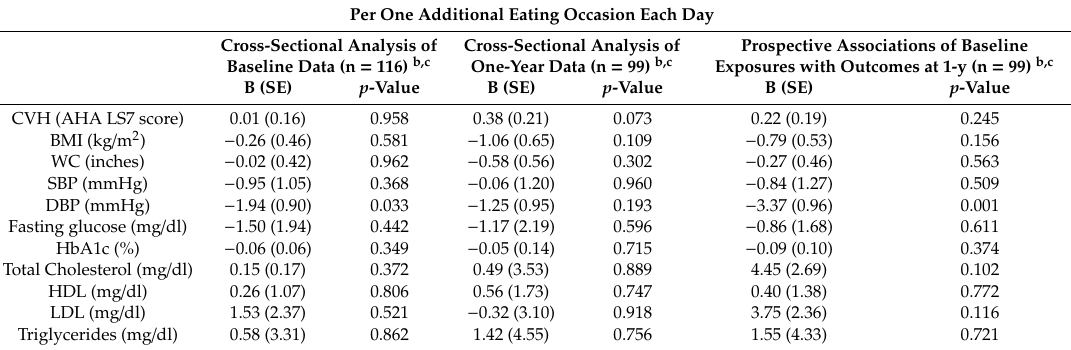
Table 4. Linear Regression Models for Cross-sectional and Prospective Associations of Habitual Eating Frequency with Cardiovascular Health and Cardiometabolic Risk Factors a